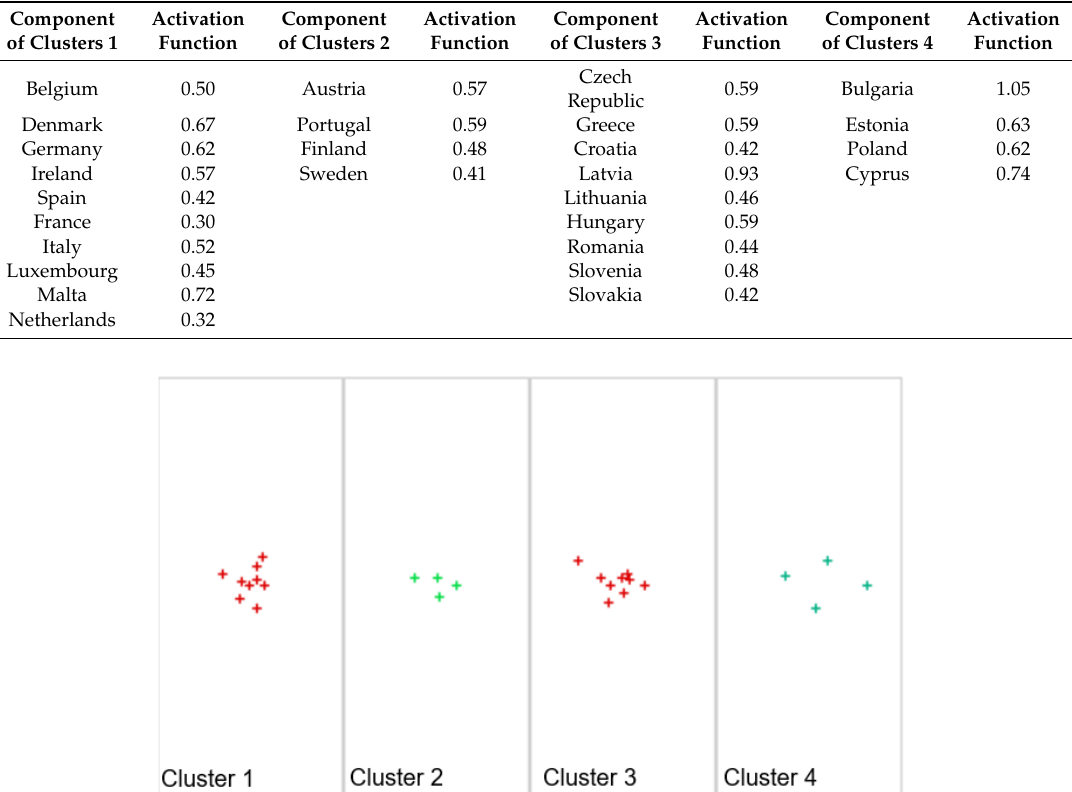
Table 5. Division of the EU-27 countries into similar groups in relation to the GDP, along with the activation values (distance from the center of clusters).